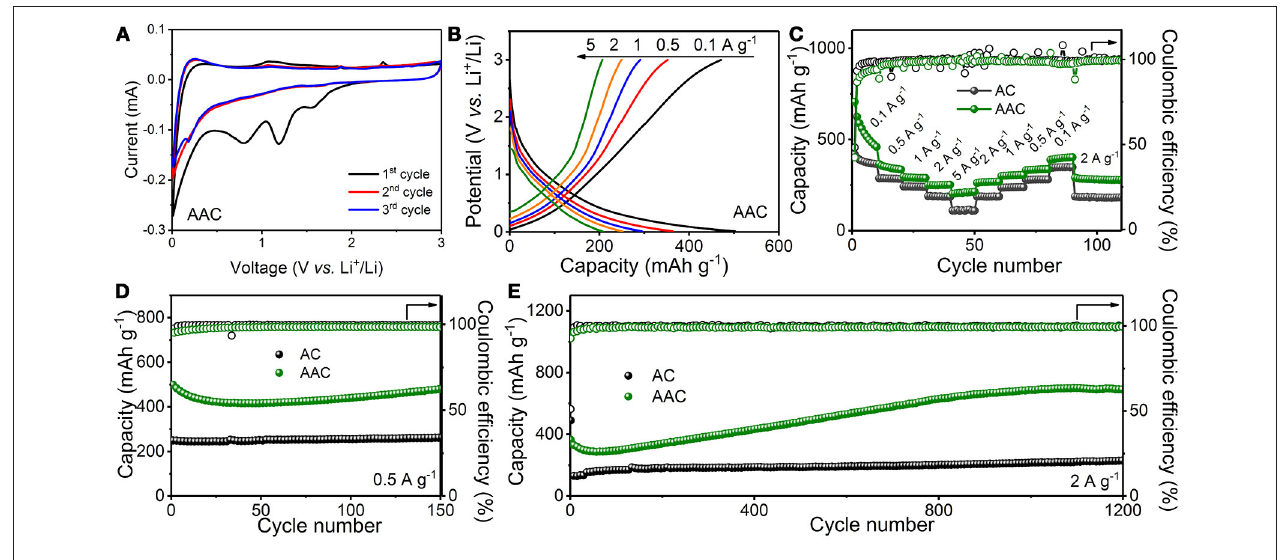
FIGURE 4 | Electrochemical performances of AAC and AC as anode materials for LIBs: (A) cyclic voltammetry (CV) curves at 0.1mV s − 1 of AAC; (B) charge/discharge curves of AAC at different current densities; (C) rate performances; (D,E) long-term cyclic performances at 0.5A g − 1 (D) and 2A g − 1 (E)